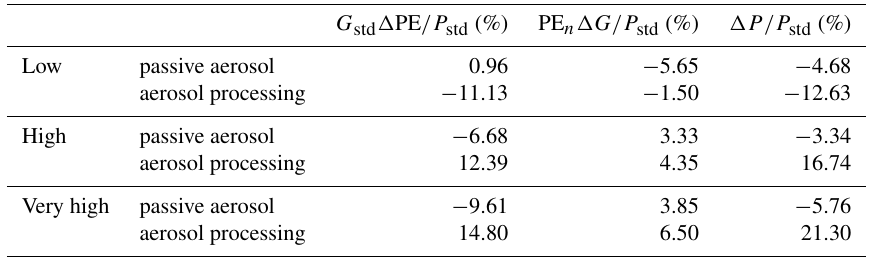
Table 4. Change in surface precipitation expected from the simulated change in PE (left column) and the change in condensate generation (middle column). The last column gives the total relative change in precipitation, as predicted by the simulations. All changes are relative to the simulation with the standard-aerosol profile. G std (cid:49) PE /P std